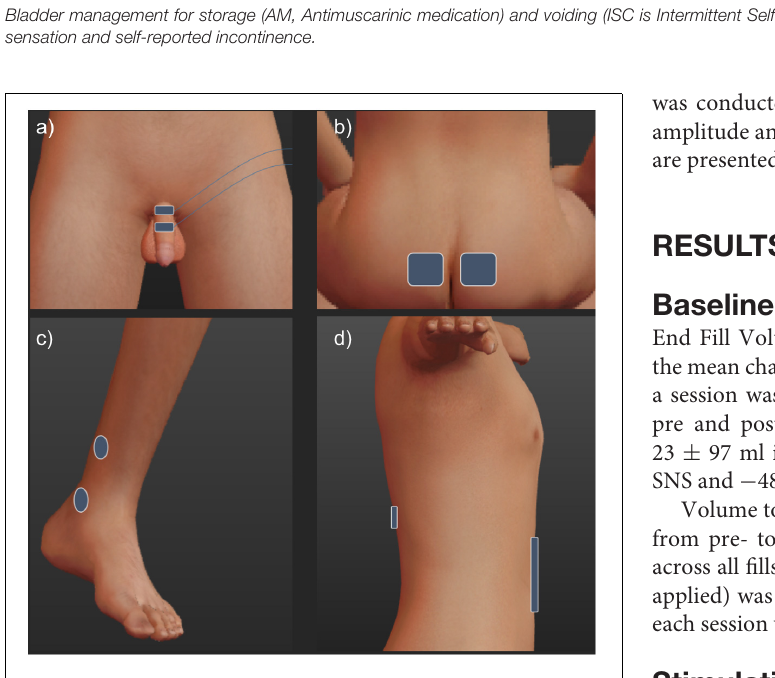
FIGURE 1 | To stimulate the dorsal genital nerve (a) , electrodes were placed on the dorsum of the penile shaft. 1 cm paddle electrodes (Ambu Neuroline 710) were placed approximately 2 cm apart, the cathode was placed proximally. Tibial nerve electrodes (c) were 2.5 cm round surface electrodes (PALS) placed unilaterally 1 cm posterior and approximately 3 cm superior to the medial malleolus (cathode) and approximately 5 cm superior (anode). Sacral electrodes (b) were 5 × 5 cm (PALS) electrodes placed over either side of the sacrum, at the level determined to be over the S3 foramina through manual palpation of the sacrum. Spinal stimulation (d) used 5 cm circular and 7.5 × 10 cm electrodes (PALS) over T11-12 and the abdominal areas, respectively (Hofstoetter et al.,